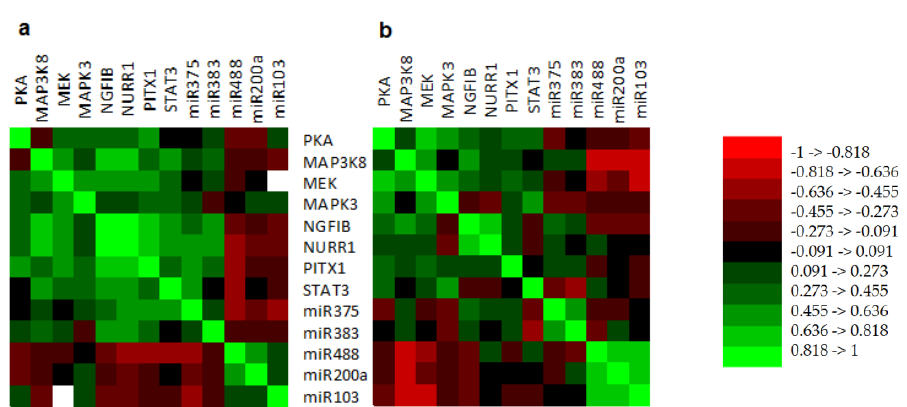
Figure 2. HeatMap between gene and pathways involved in the silencing of corticotroph tumors. ( a ) Functioning corticotroph tumors (n = 24); ( b ) Silent corticotroph tumors (n = 23). Legend of numbers associated with colors refers to the coefficients of correlation.